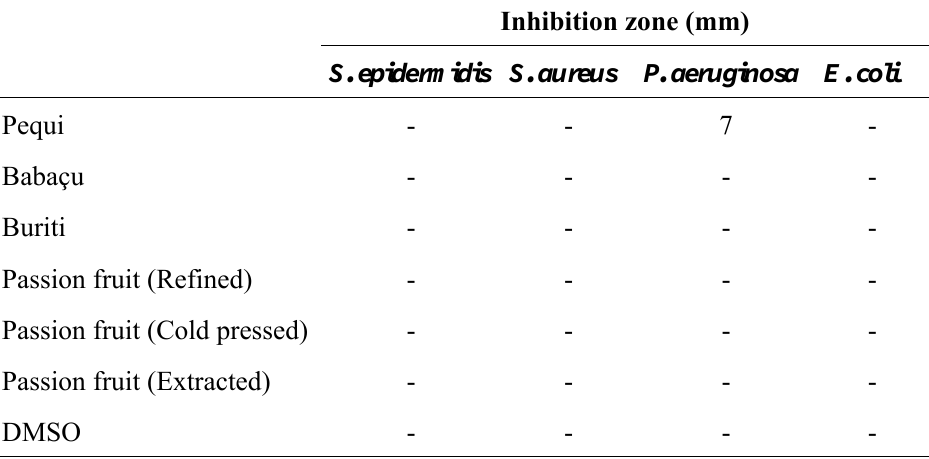
Table 3. Antibacterial